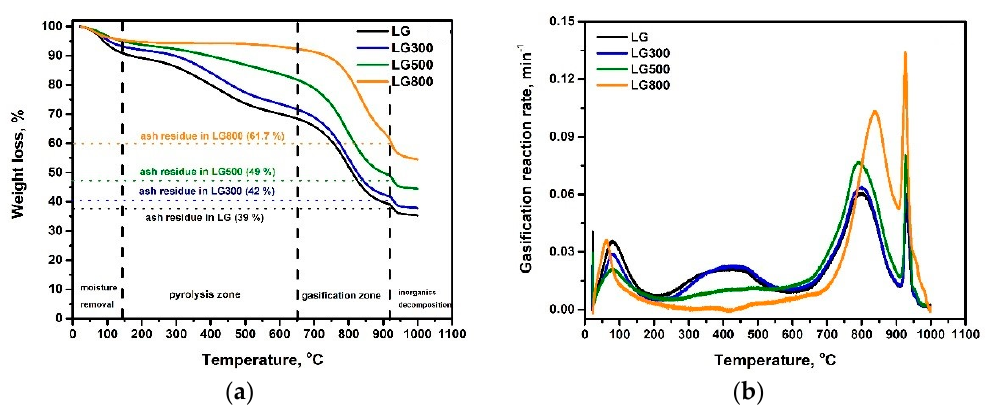
Figure 5. Non-isothermal thermogravimetric analysis ( a ), and instant gasification rate ( b ), for raw lignite and chars under pure CO 2 atmosphere.